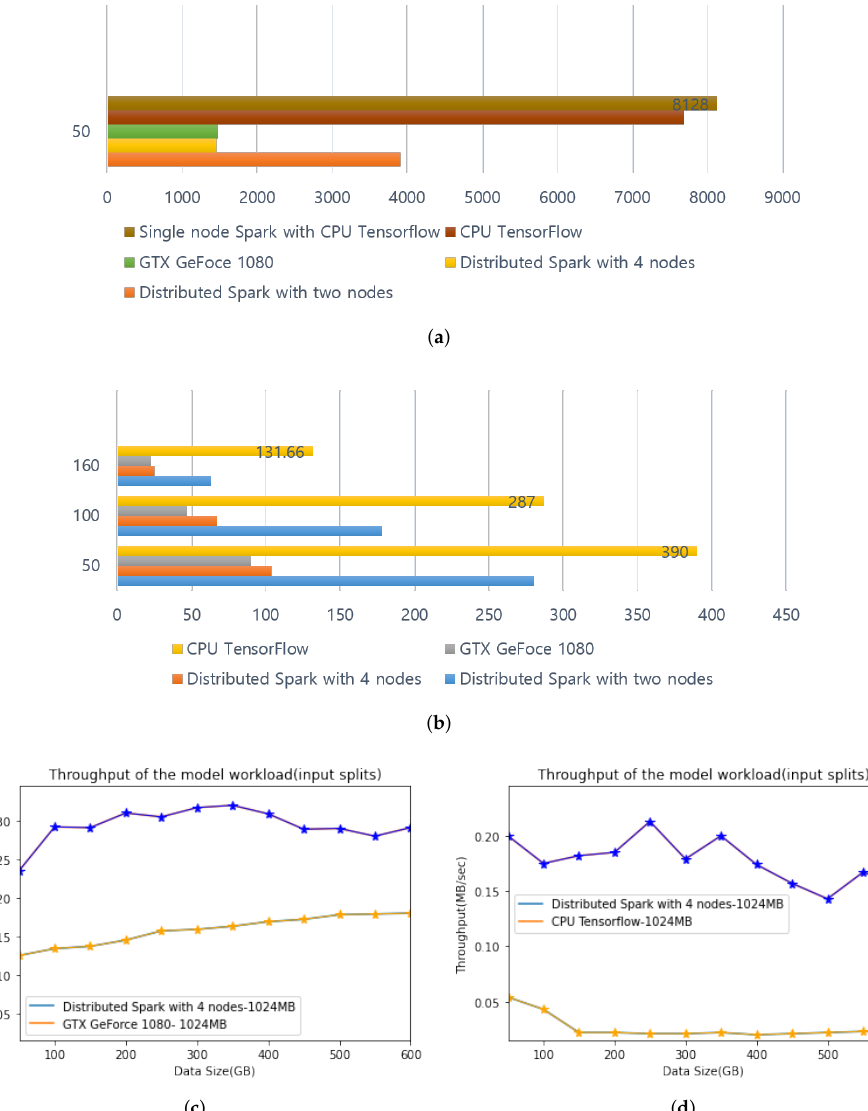
Figure 9. A set of four subfigures: ( a ) describes the Performance comparison between Apache Spark, GPU, and CPU; ( b ) describes the Performance comparison between Apache Spark, GPU, and CPU by varying the batch size; ( c ) describes the Throughput of model workload; ( d ) describes the Throughput comparison between spark and